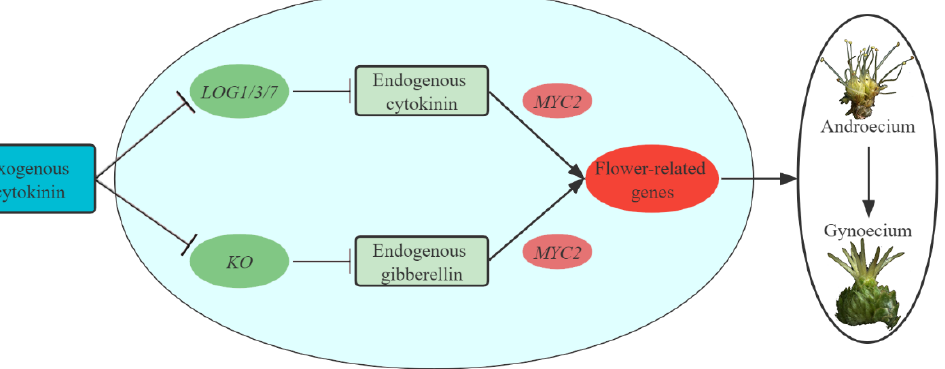
Figure 12. A schematic model for the role of cytokinin in the regulation of sex determination in Castanea henryi . Arrows and blunt arrows represent positive and negative regulations, respectively.